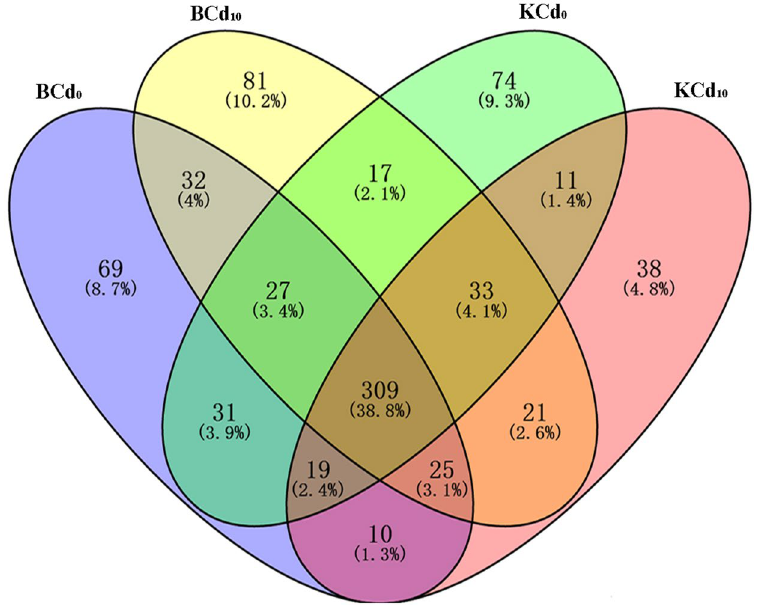
Figure 3. The all detected ROS-mediated related genes expression showed in Venn